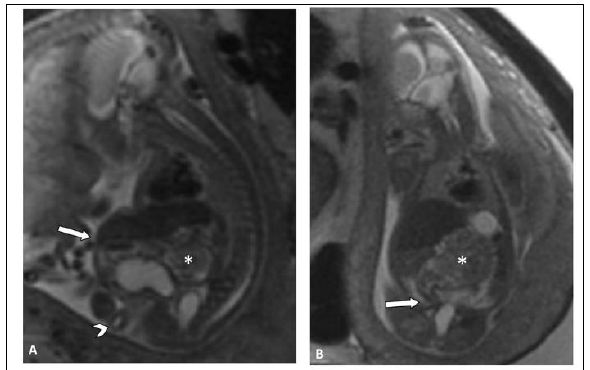
Figure 1: Congenital pouch colon, megalourethra, and prune belly syndrome on fetal MRI (3T) in a 30-year-old woman at 20 weeks 1 day. A) Sagittal T2WI shows the protuberant abdomen characteristic of prune belly syndrome, dilated and fluid-filled penile urethra (arrowhead), and pouch colon (*). B) Coronal T2WI shows abrupt tapering of the pouch colon (*) at the level of the rectosigmoid junction (arrow). The patient was induced at 36 weeks and 5 days for fetal growth restriction and delivered